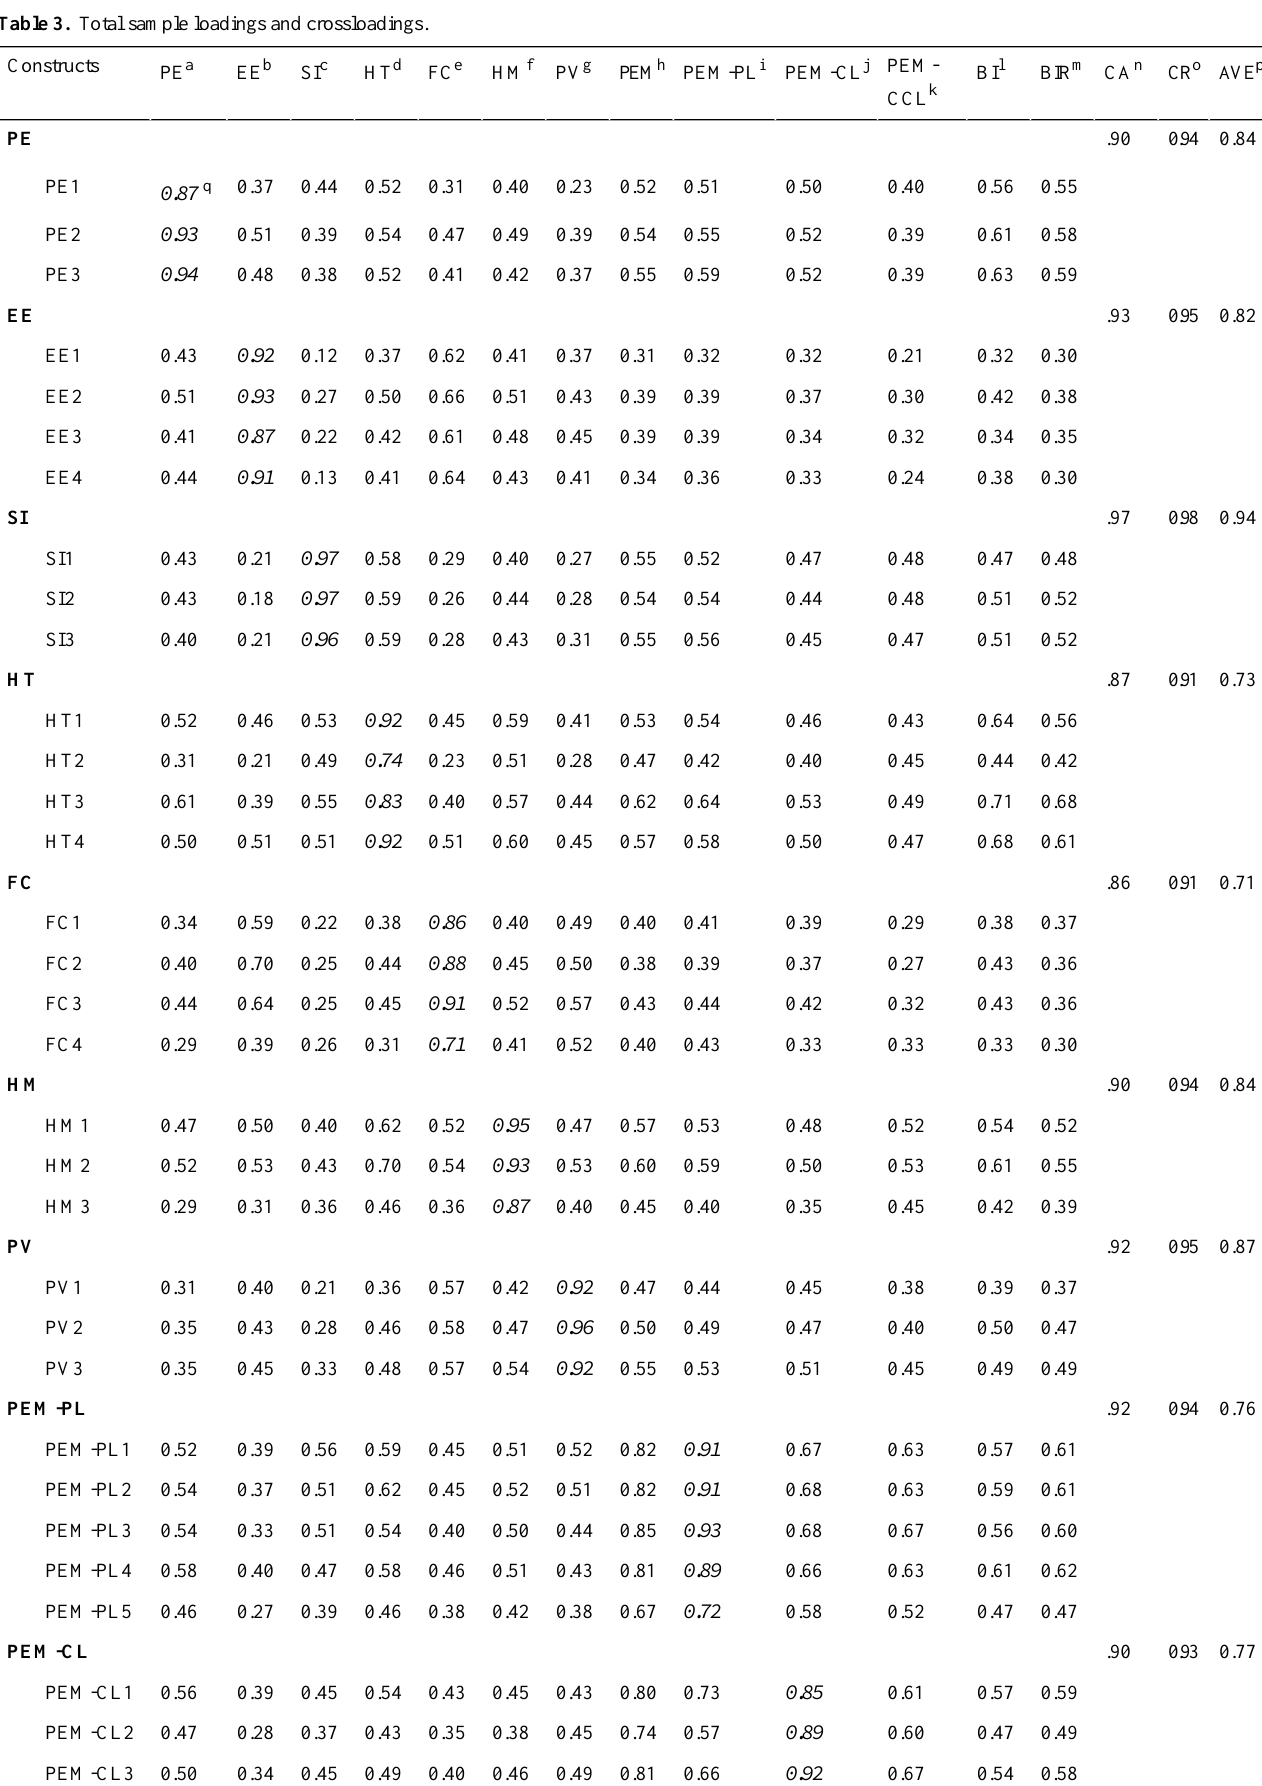
Table 3. Total sample loadings and crossloadings.